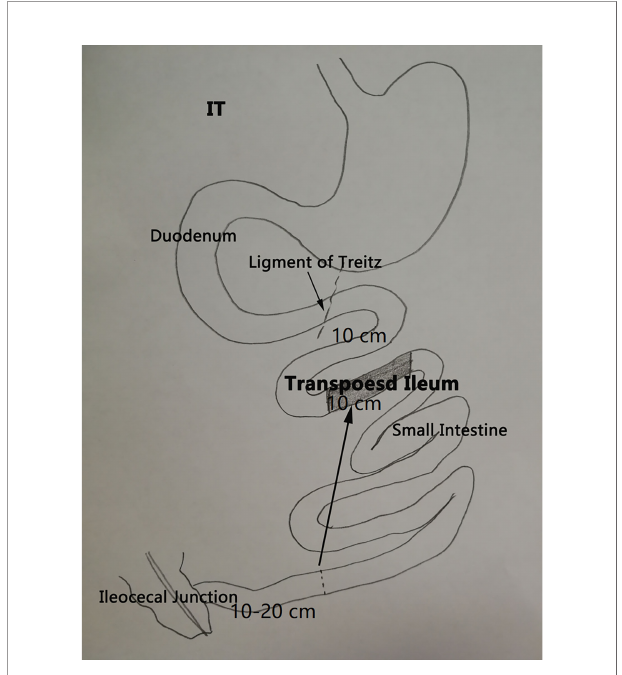
FIGURE 1 | Schematic diagram of ileal